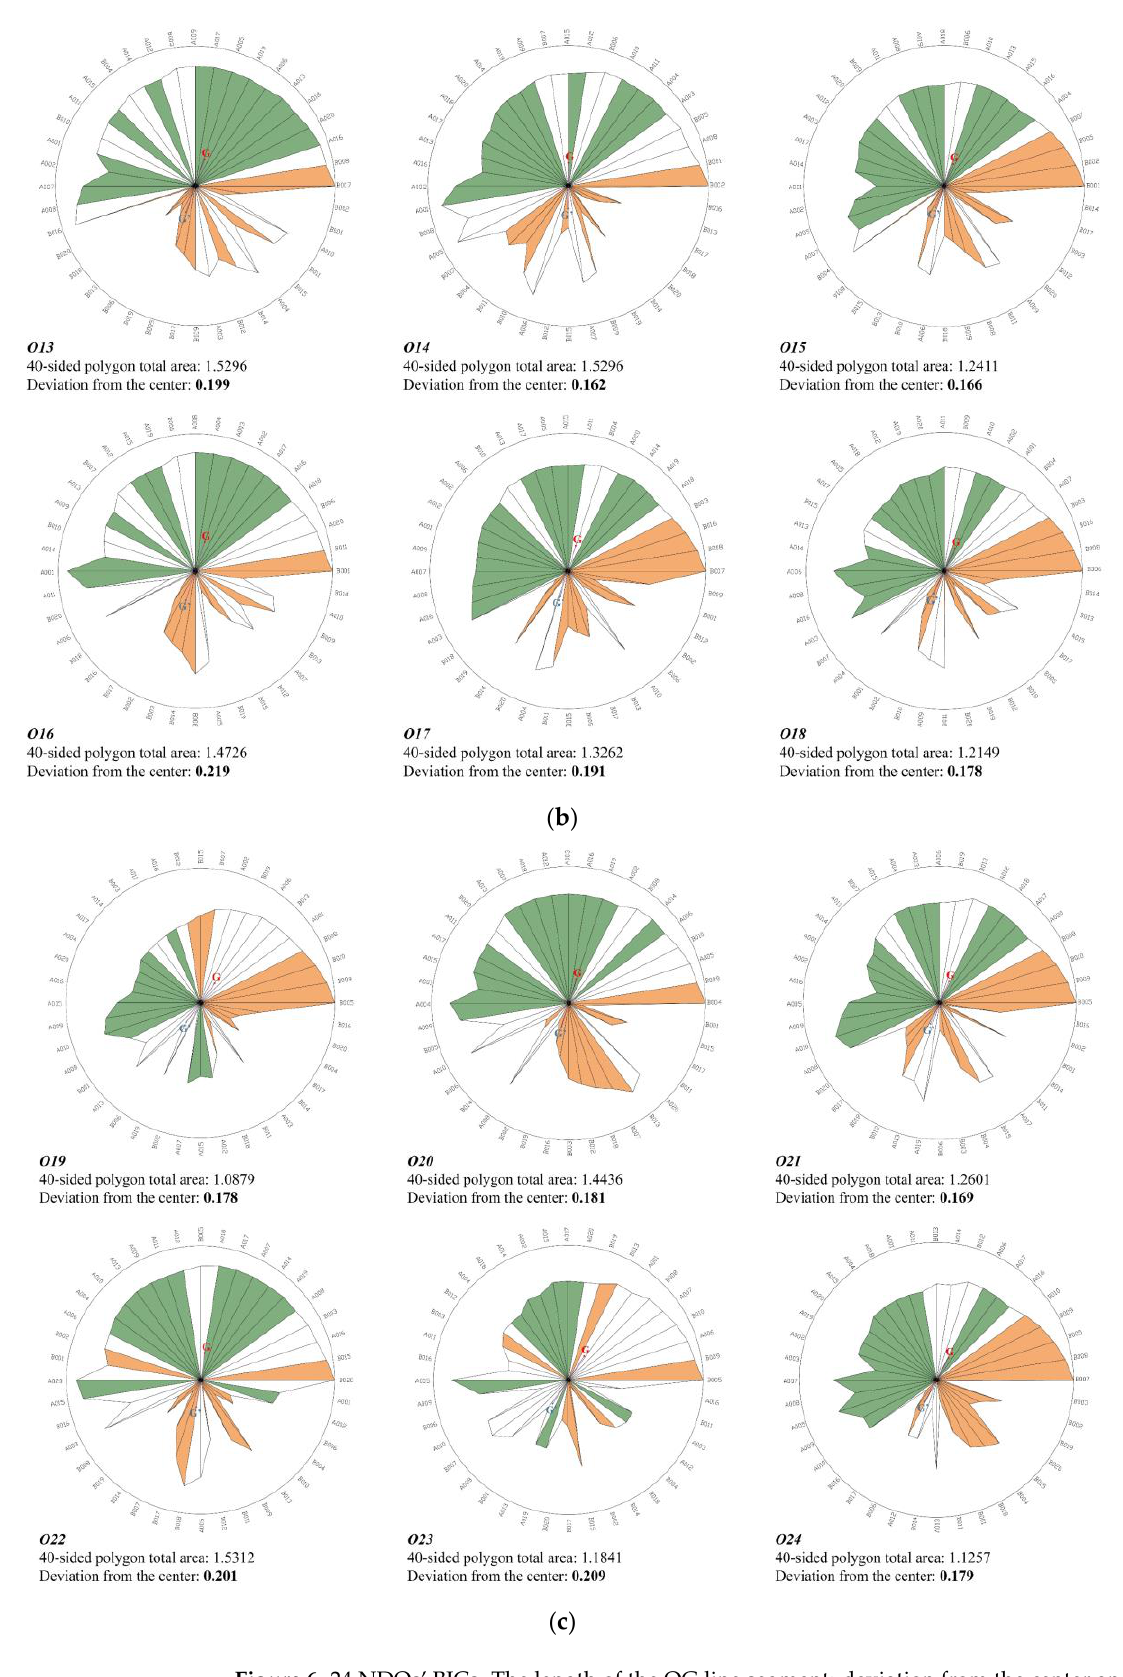
Figure 6. 24 NDOs ’ BICs. The length of the OG line segment: deviation from the center and the area of the formed geometric shape: 40-side polygon total area: ( a ) Cluster 1; ( b ) Cluster 2; ( c ) Cluster 3.